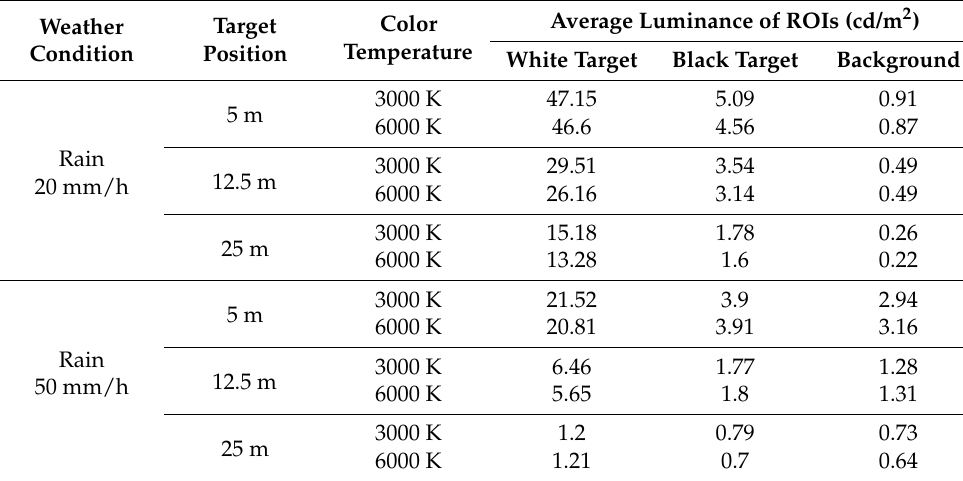
Table A3. Average luminance of ROI in rain conditions (cd/m 2